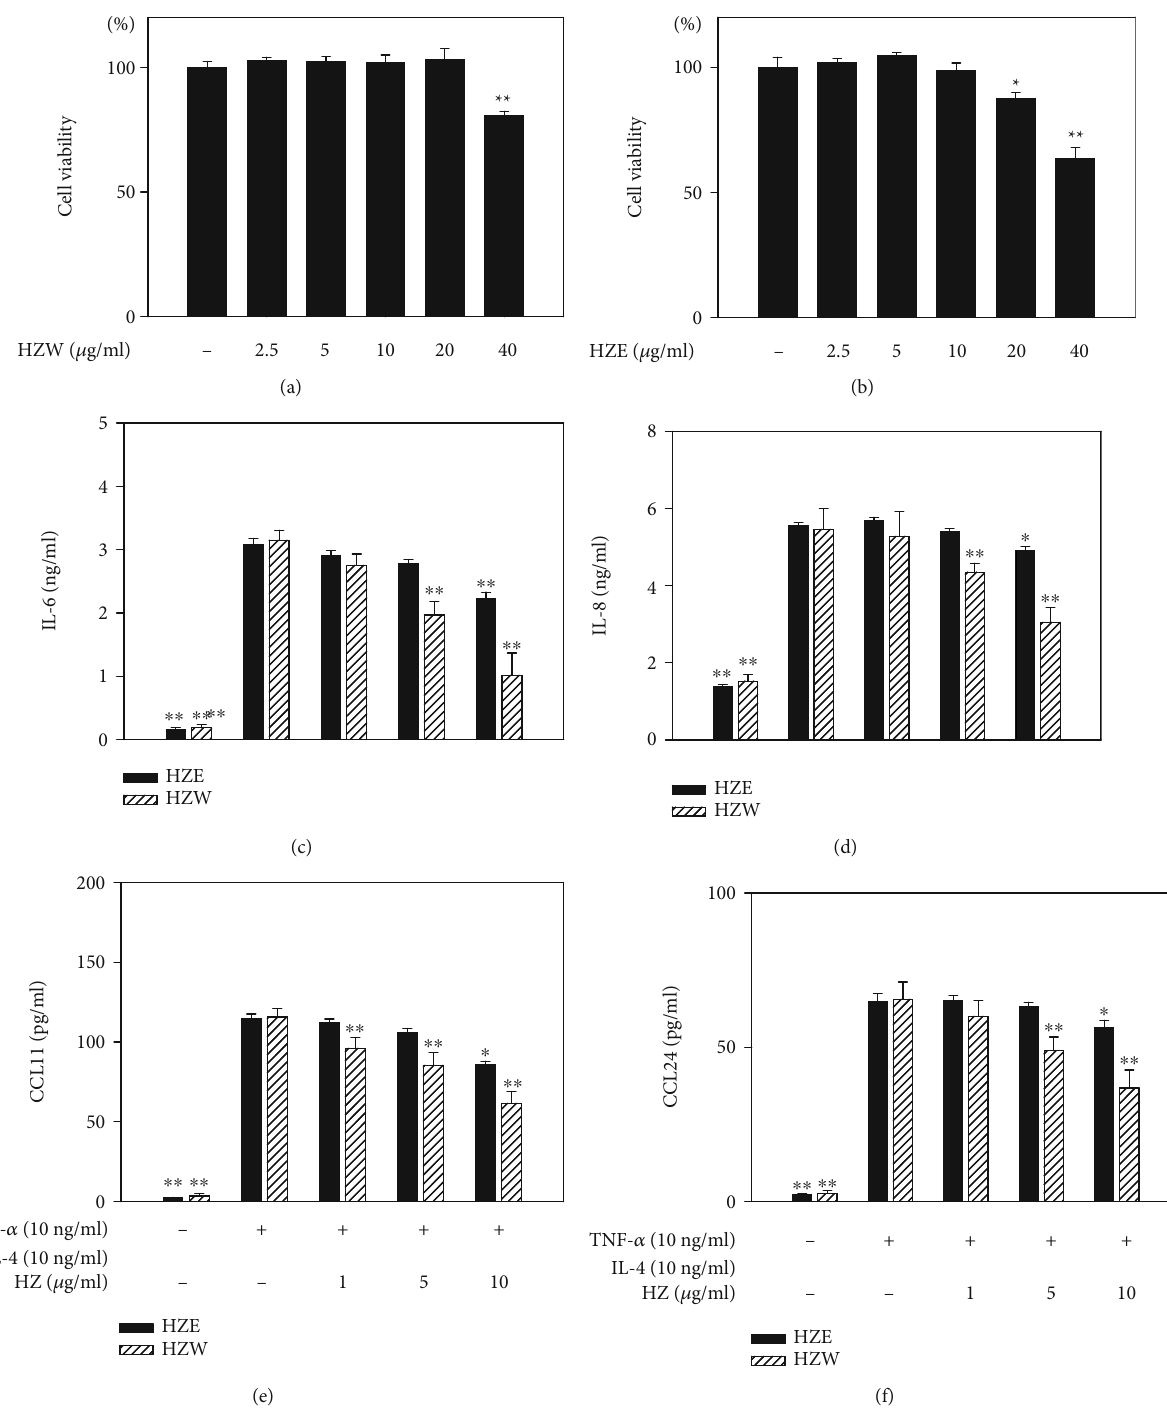
Figure 2: The e ff ects of HZW and HZE on cytokine and chemokine productions in BEAS-2B cells. Cell viability of (a) HZW and (b) HZE in BEAS-2B cells. The levels of IL-6 (c), IL-8 (d), CCL11 (e), and CCL24 (f) were measured by ELISA. All data are presented as the mean ± SEM . ∗ P < 0 : 05 and ∗∗ P < 0 : 01 compared with BEAS-2B cells stimulated with TNF- α /IL-4. HZ: Helminthostachys zeylanica . HZW was dissolved in PBS and HZE was dissolved in DMSO. Hence, vehicle HZE experiment contained 0.1% DMSO in medium and vehicle HZW experiment did not contain DMSO in